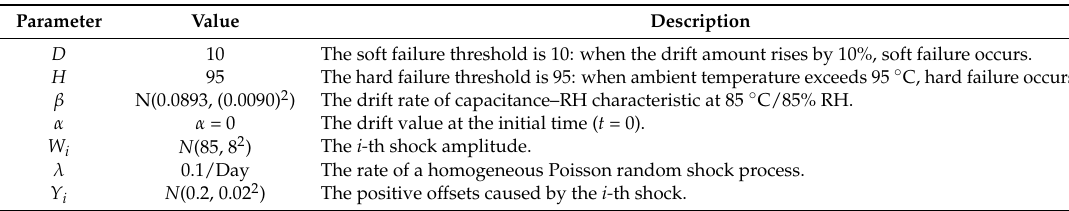
Table 3. Parameters of the reliability model for example